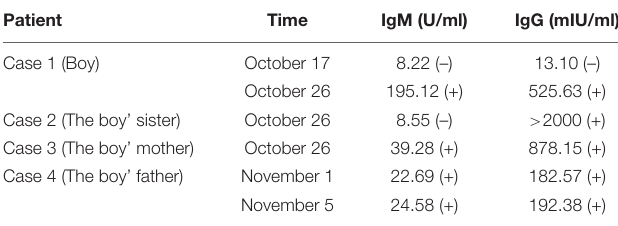
TABLE 1 | Anti-VZV IgM and IgG results for the family members.